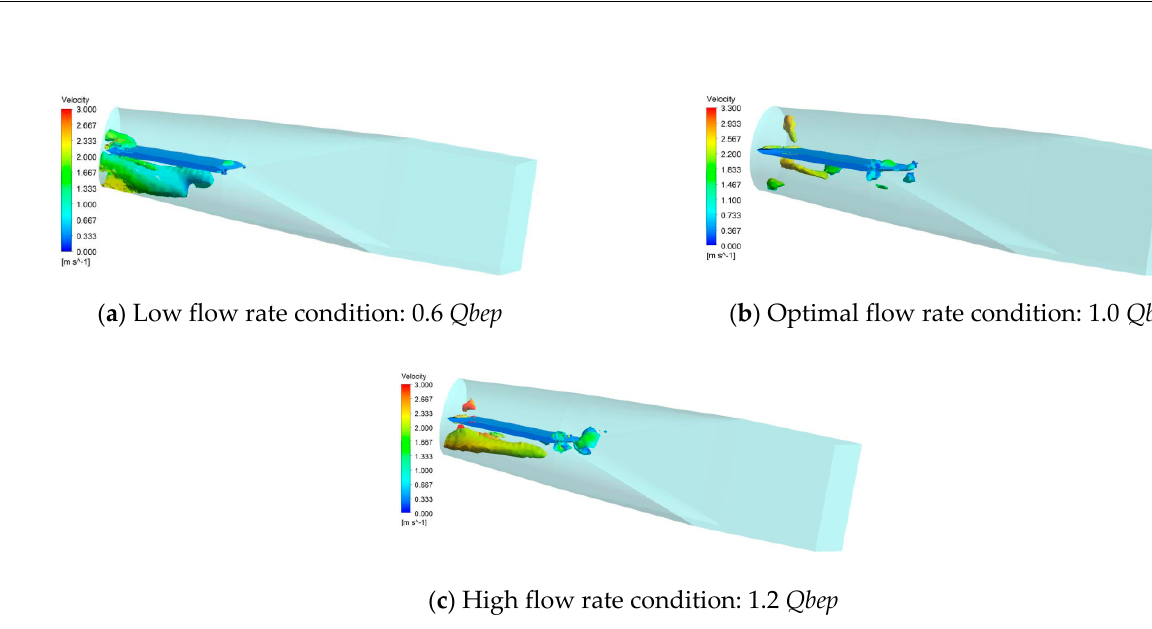
Figure 15. Vortex structure of the straight outlet conduit under different flow rate conditions ( Q = 300 s − 2 ). When the threshold value Q = 300 s − 2 , along the flow direction, vortex structures with different sizes appeared on the right side of the division pier: under the condition of a low flow rate, there was a large vortex structure on the right side of the division pier; under the optimal flow rate condition, the size of the vortex structure on the right side of the division pier decreased greatly; and under the condition of a large flow rate, the vortex structure on the right side of the division pier became larger, but the range was smaller than that